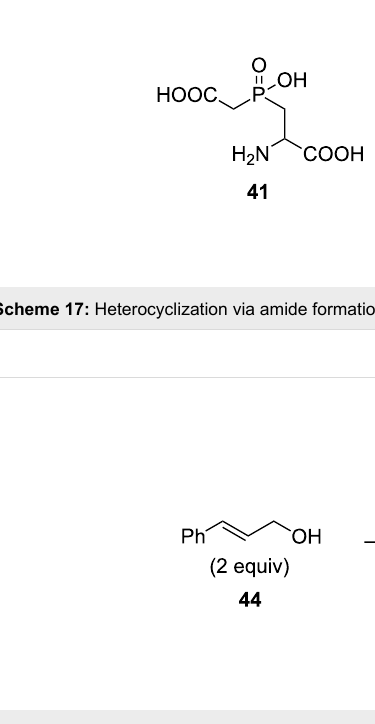
Scheme 18: Cyclization via reductive